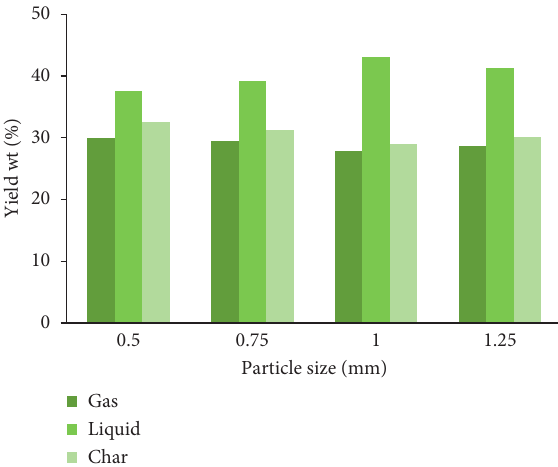
Figure 4: Effect of particle size on pyrolysis product